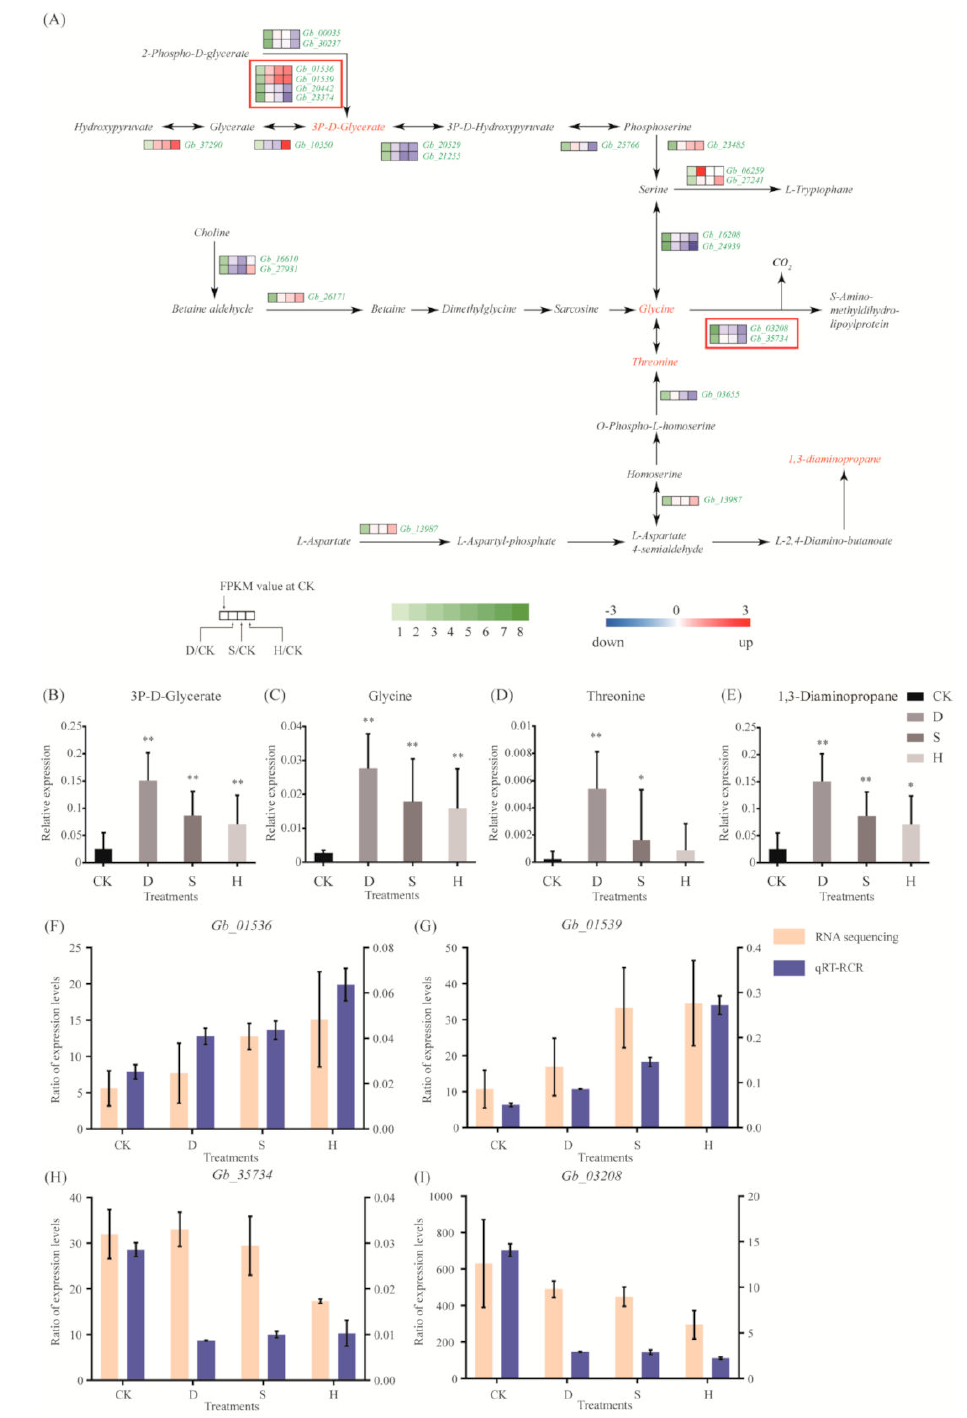
Figure 4. Gene expression and metabolites involved in the glycine, serine, and threonine metabolic pathways. ( A ) DEGs associated with these pathways. Red and blue indicate upregulation and downregulation, respectively. Red frames indicate the upregulated or downregulated genes discussed in the main text. ( B – D ) Expression of ( B ) 3P-D-glycerate, ( C ) glycine, ( D ) threonine, and ( E ) 1,3-diaminopropane. Error bars represent the mean ± SD; n = 5; * / **, p < 0.05 / 0.01, respectively, compared with CK. ( F – I ) Expression of ( F ) Gb_01536 , ( G ) Gb_01539 , (H) Gb_35734, and (I) Gb_03208 , as determined by qRT-PCR. Error bars represent the mean ± SD; n = 3. CK: Control; D: Drought; S: Salt; H: